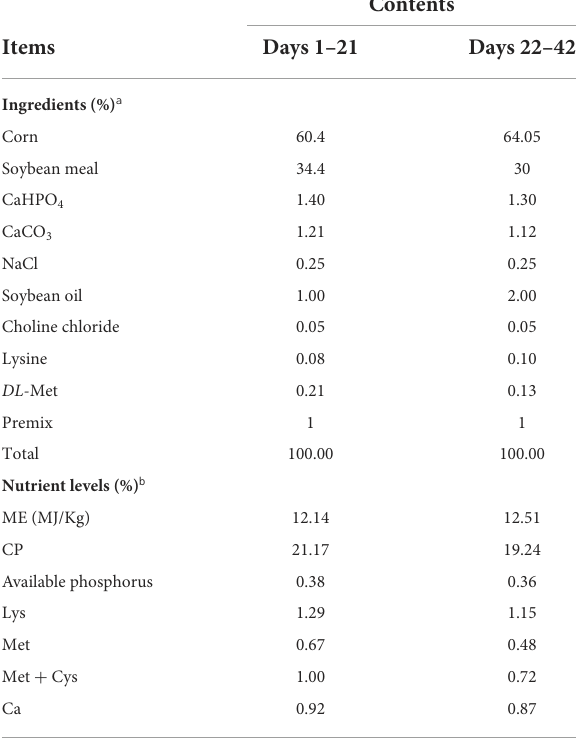
TABLE 1 Composition and nutrient levels of the basal